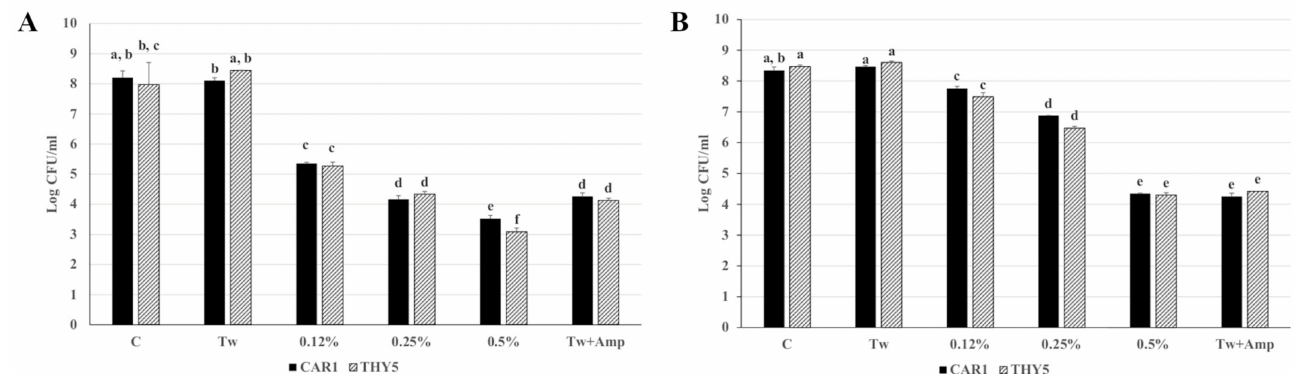
Figure 2. Direct contact test of CAR1 and THY5 antimicrobial activity ( A ) against L. monocytogenes OH and ( B ) S. Typhimurium LT2. Each EO was tested at 0.12, 0.25 and 0.5% concentrations. C: 0% EO; CTw: 0% EO + 0.125% Tween 80; CTw + Amp: 50 µ g/mL ampicillin + 0.125% Tween 80. Bacterial cell viability is expressed as the geometric mean of CFU/mL ± SD of one experiment carried out in triplicate. Means without a common letter significantly differ, p <